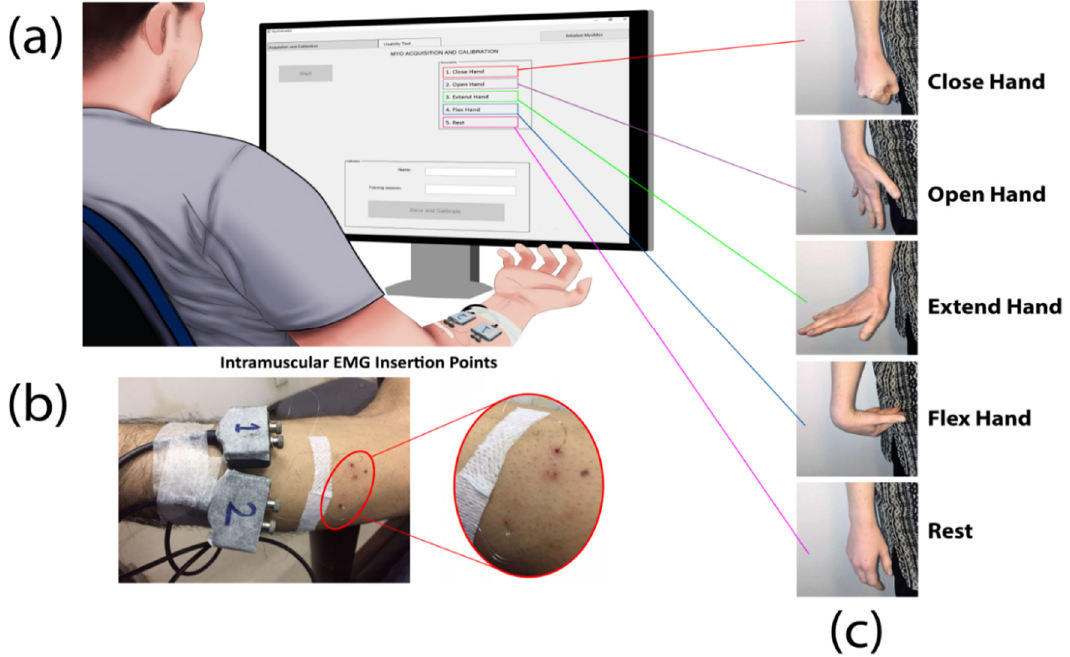
Figure 1. ( a ) GUI interface during the training session. Each motion was graphically displayed to the subject during training with the time-cue. ( b ) Intramuscular electrode insertion sites on the forearm of one of the subjects participated in the experiment. ( c ) Motions that each subject performed during the training